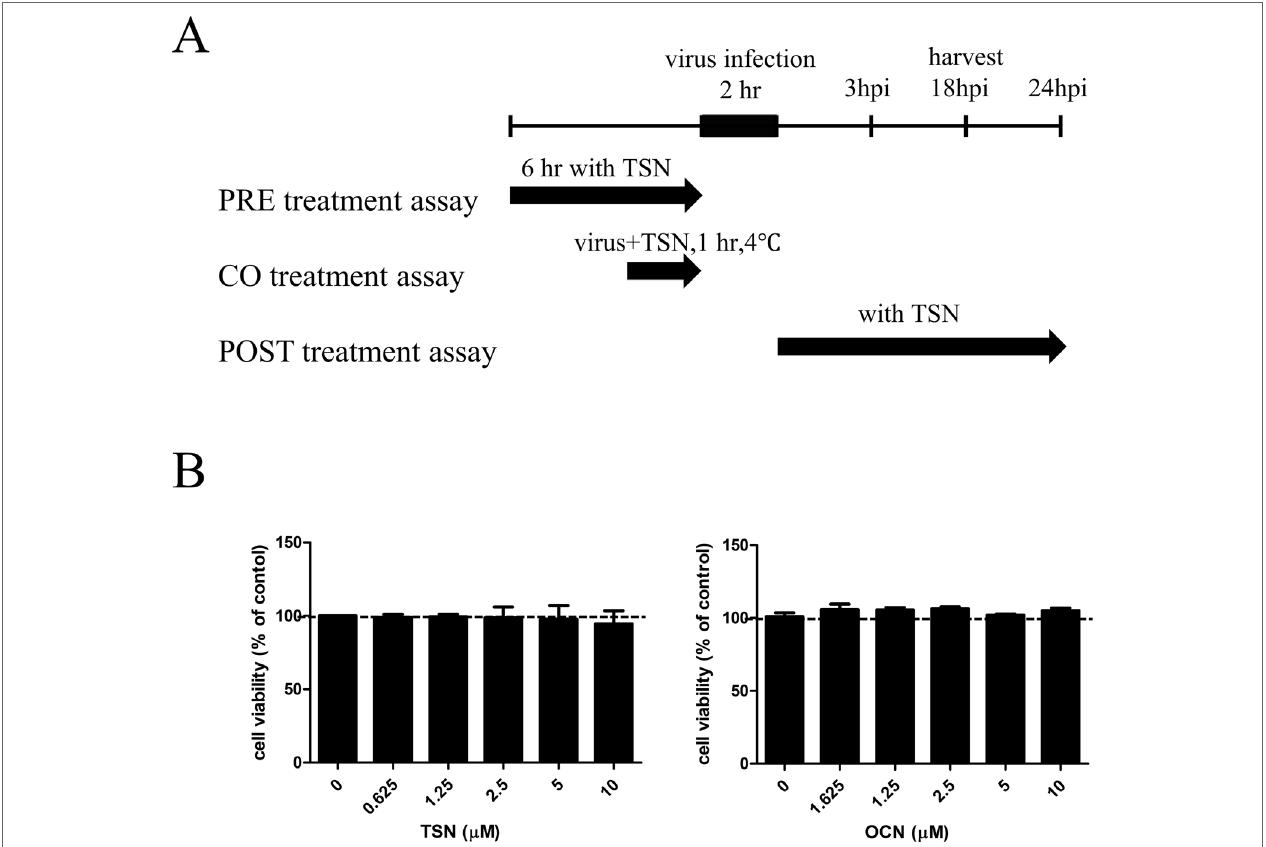
FIGURE 2 | Schematic diagram of the anti-influenza virus assay and cytotoxicity assay for TSN and OCN in MDCK cells. (A) In the pretreatment assay, MDCK cells were treated with various TSN concentrations for 6 h before infection with 10 MOI influenza A virus. In the cotreatment assay, 10 MOI influenza virus and various concentrations of TSN were first mixed and incubated at 4°C for 1 h before addition to MDCK cell cultures for 2 h. In the posttreatment assay, MDCK cells were first infected with influenza A virus for 2 h at 37°C and then treated with TSN for the indicated time. (B) The viability of MDCK cells was analyzed by MTS assay after 24-h treatment with the indicated concentrations of TSN or OCN (up to 10 µM) (TSN CC 50 >